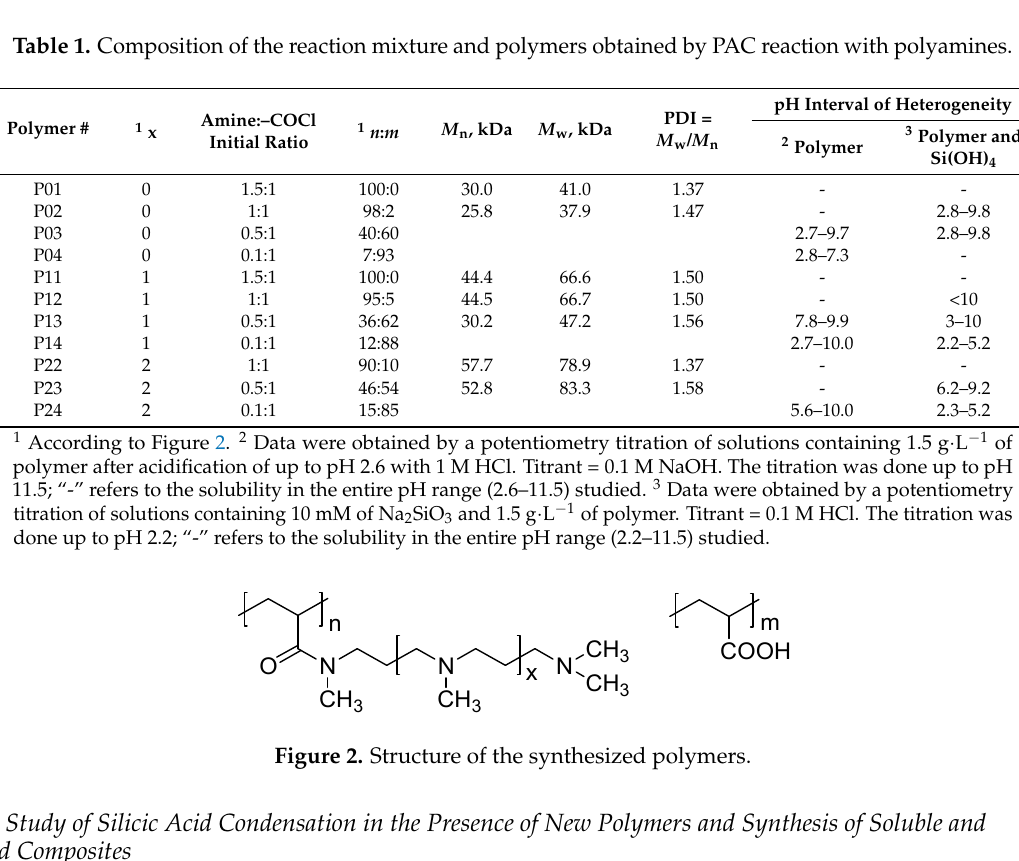
Table 1. Composition of the reaction mixture and polymers obtained by PAC reaction with polyamines.